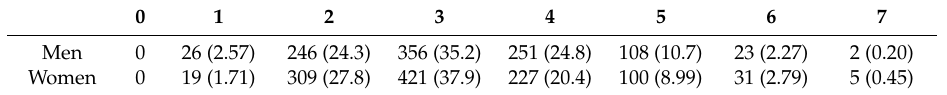
Table 3. Prevalence of adherence to cancer prevention guidelines by sex in the Health ABC Study, n (%).